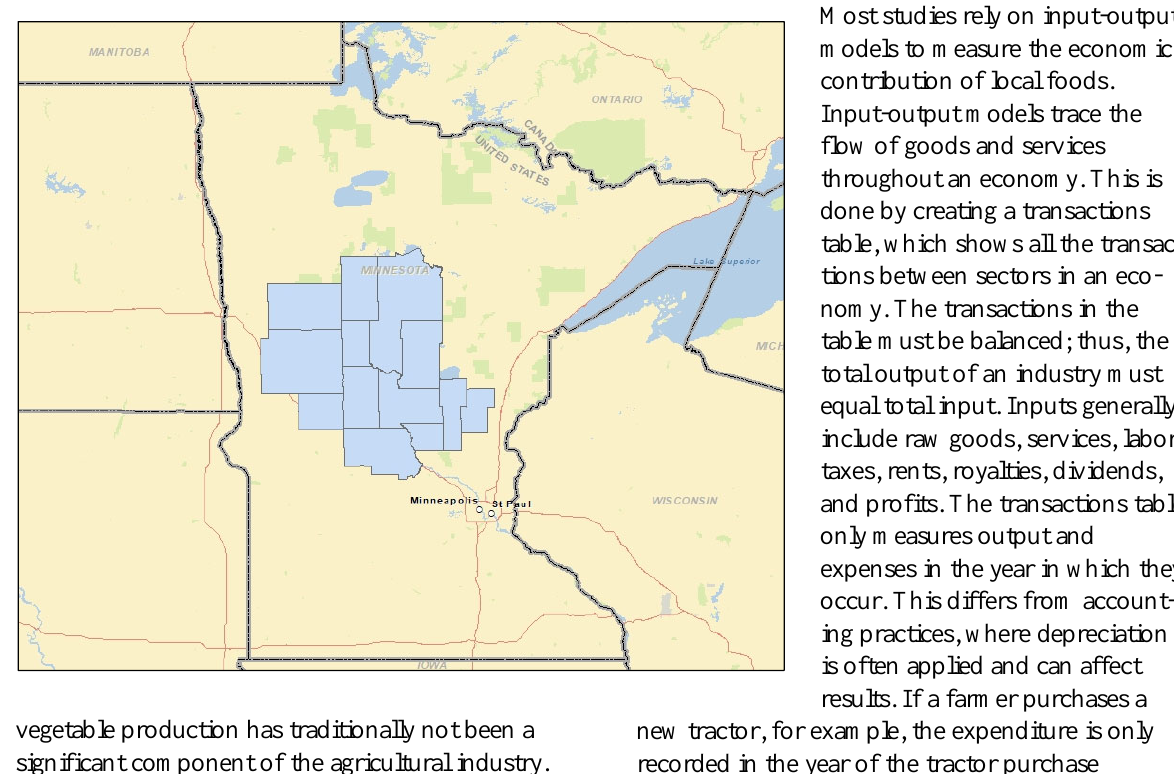
Figure 1. Central Minnesota Study Area (in